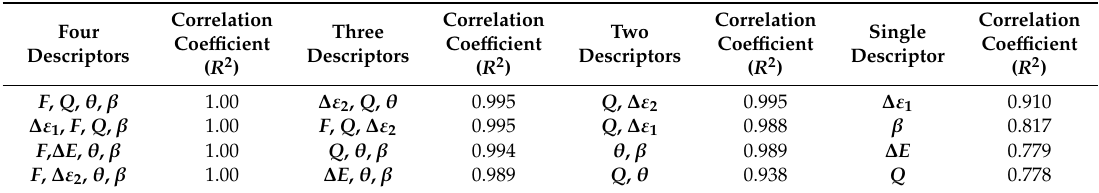
Table 8. Correlation coe ffi cient ( R 2 ) values for Ni1 – Ni2 analogue system for selected combinations of four, three, two and one